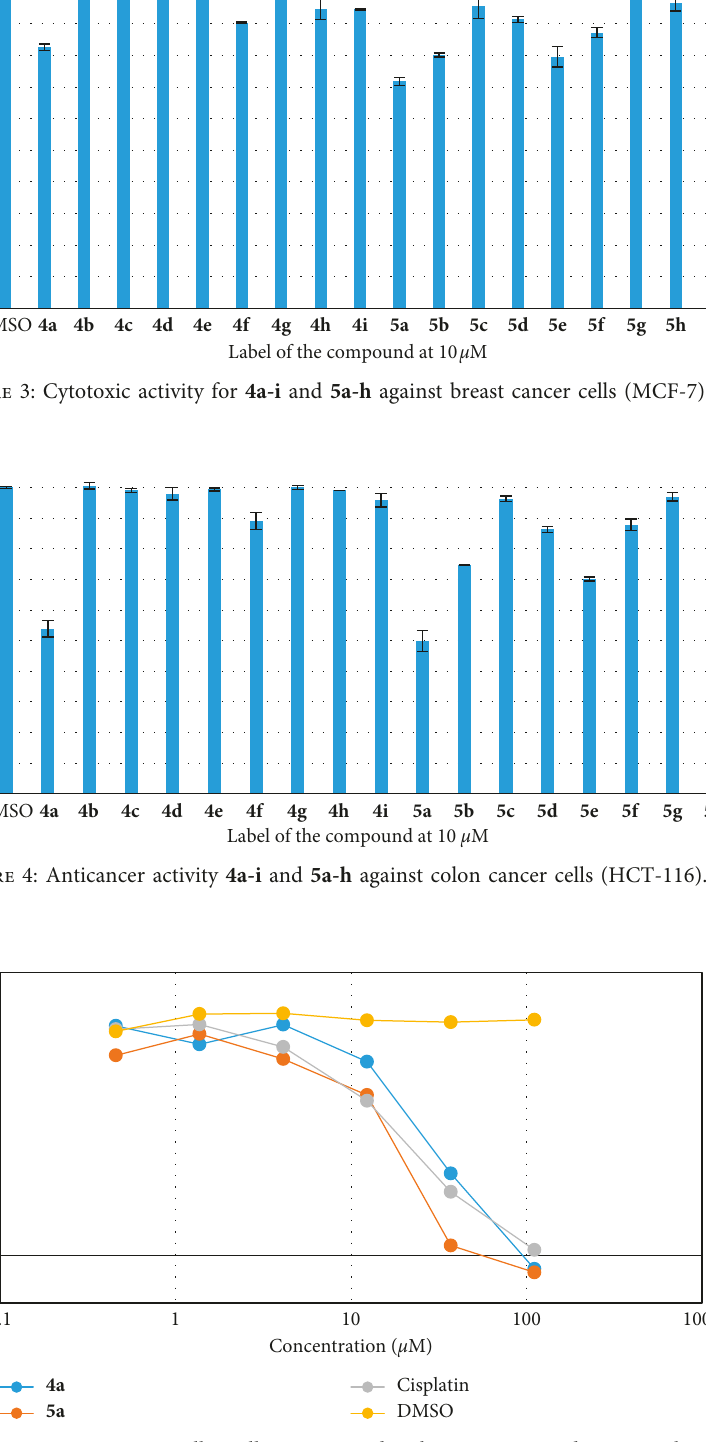
Figure 5: Cytotoxicity of 4a and 5a against MCF-7cells. Cells were treated with DMSO, 4a , and 5a or cisplatin for 48hours and then the viability was determined by MTT assay.